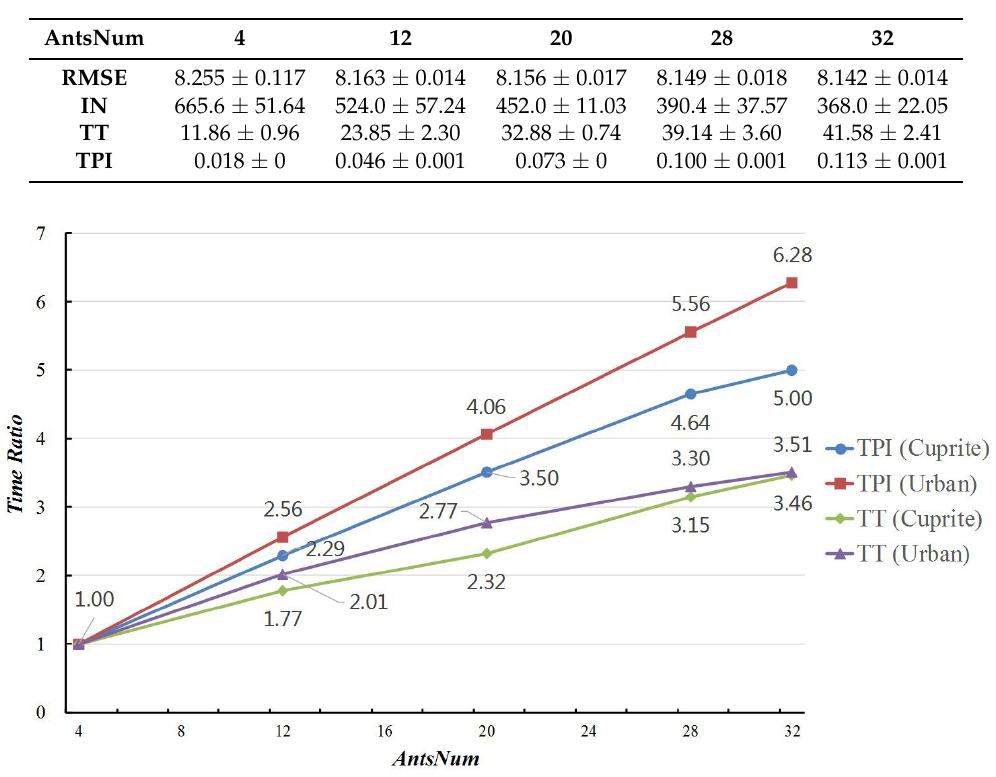
Table 13. Comparison of different AntsNum in MG-ACOEE on the parallel performance for Urban data.